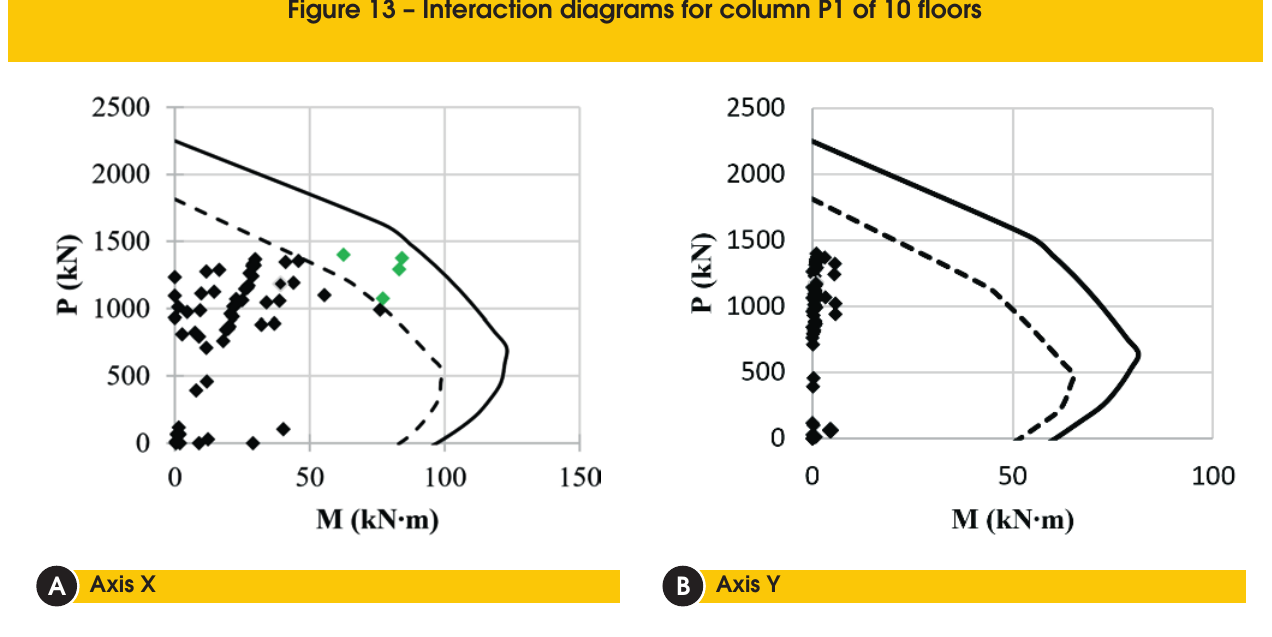
Figure 13 – Interaction diagrams for column P1 of 10